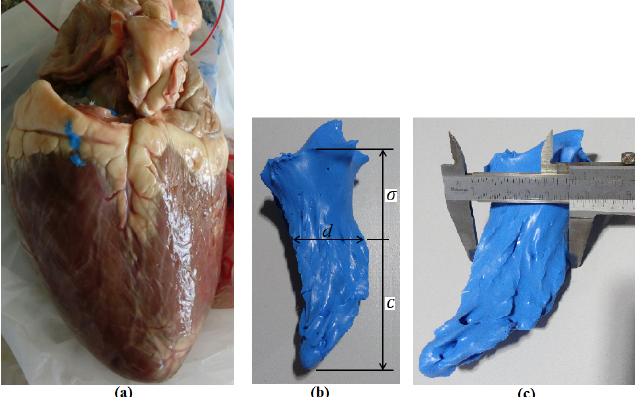
Figure 3. ( a ) One of the hearts used to manufacture the molds; ( b ) one of the molds obtained, and the indication of the measurements taken; and ( c ) the measurement of the final diastolic diameter, obtained with a caliper, considering this measurement as the largest diameter obtained in the